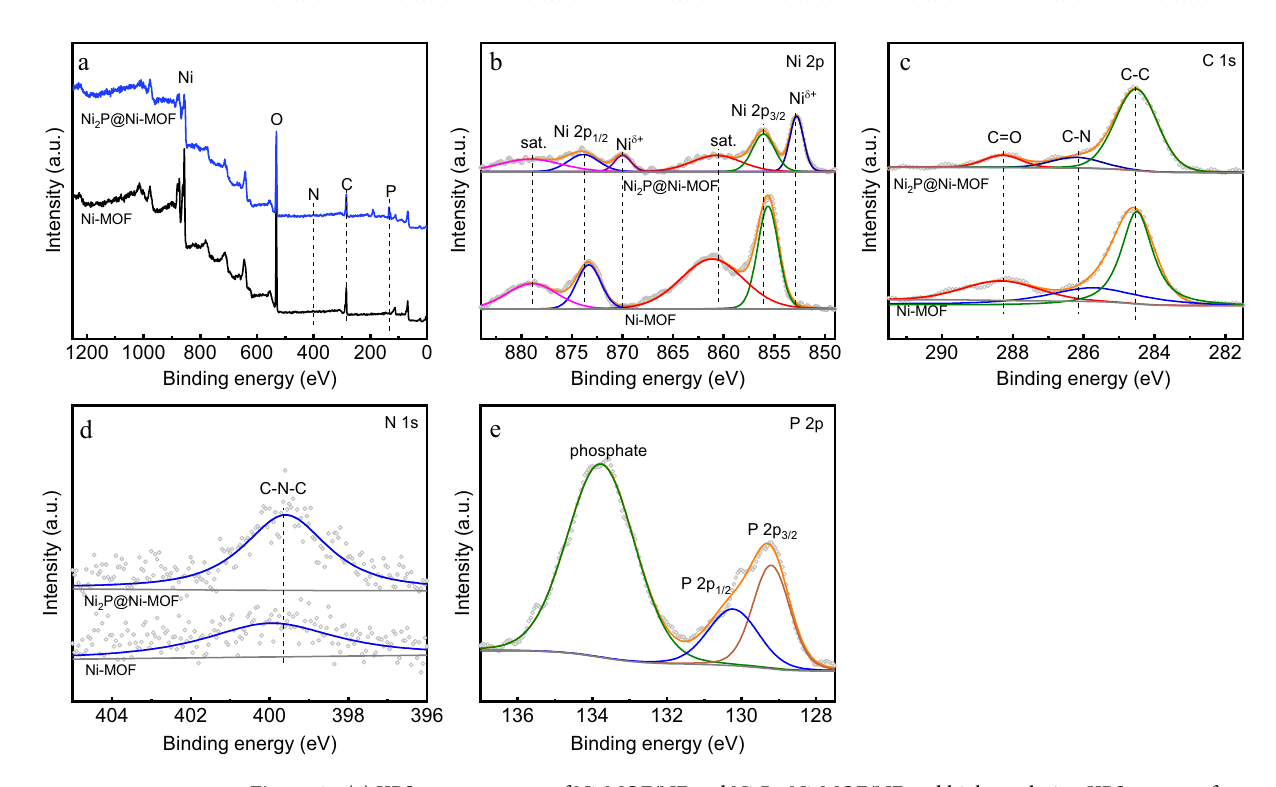
Figure 4. ( a ) XPS survey spectra of Ni-MOF/NF and Ni 2 P@Ni-MOF/NF and high resolution XPS spectra of ( b ) Ni 2p, ( c ) C 1 s, ( d ) N 1 s and ( e ) P 2p. All of the spectra were calibrated by C1s peak located at 284.8